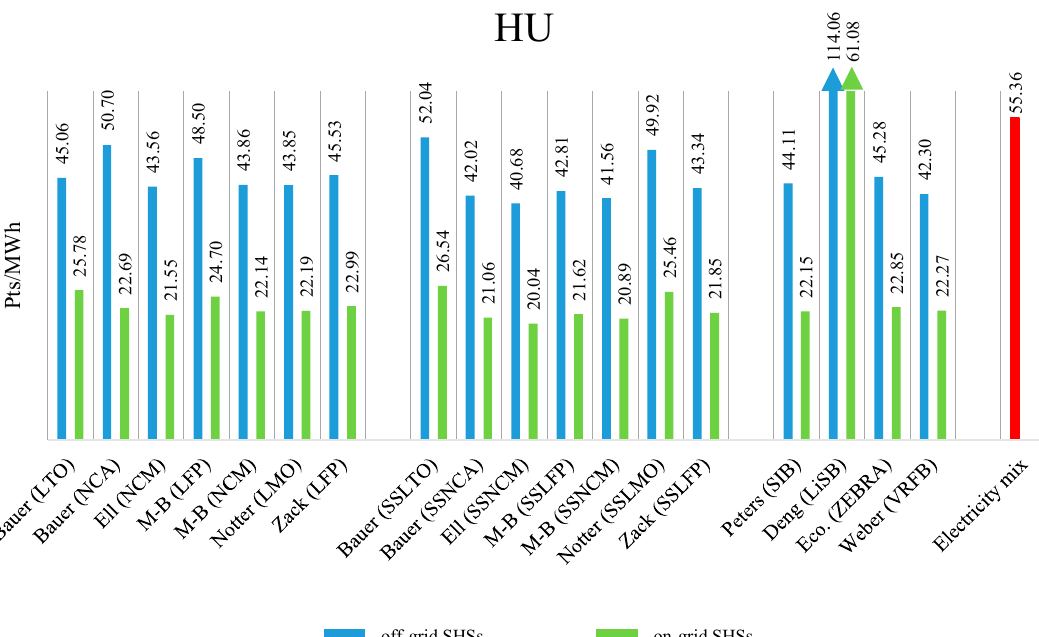
Figure 8. LCA impact values of SHSs in Greece as single scores. Energies 2020 , 13 , x FOR PEER REVIEW